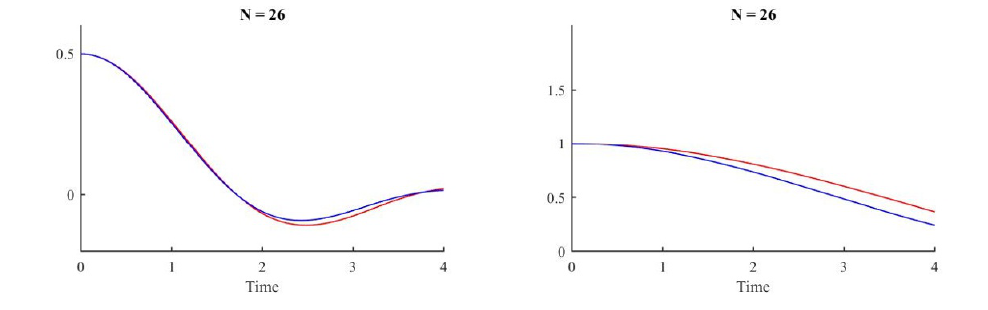
Figure 14 . We compare the expectation value of h 1 ( t ) 1 (0) i (left) and h S 1 ( t ) S 1 (0) i (right) in the thermal state (blue) and pure state (red). We expect the two curves to di(cid:11)er by corrections suppressed by 1 =N . The observed deviation is consistent with the value of N that we